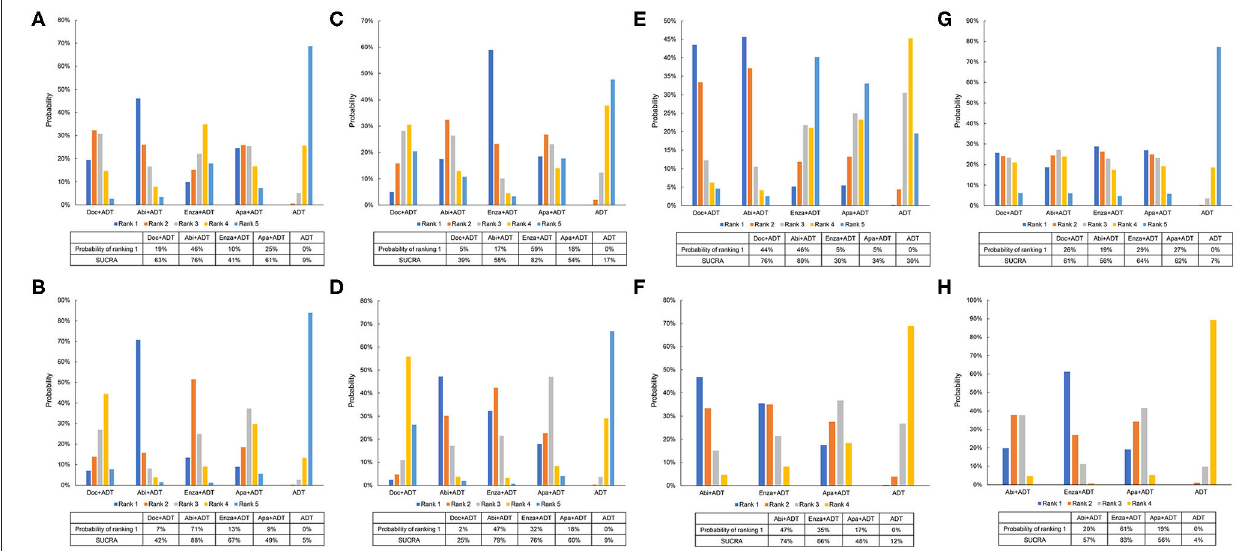
FIGURE 5 | Ranking probabilities of effective therapies for overall survival and failure-free survival. (A) Ranking probabilities of effective therapies for overall survival in patients with high-volume diseases. (B) Ranking probabilities of effective therapies for failure-free survival in patients with high-volume diseases. (C) Ranking probabilities of effective therapies for overall survival in patients with low-volume diseases. (D) Ranking probabilities of effective therapies for failure-free survival in patients with low-volume diseases. (E) Ranking probabilities of effective therapies for overall survival in patients with visceral metastases. (F) Ranking probabilities of effective therapies for failure-free survival in patients with visceral metastases. (G) Ranking probabilities of effective therapies for overall survival in patients without visceral metastases. (H) Ranking probabilities of effective therapies for failure-free survival in patients without visceral metastases. Doc, docetaxel; Abi, abiraterone; Enza, enzalutamide; Apa, apalutamide; ADT, androgen-deprivation